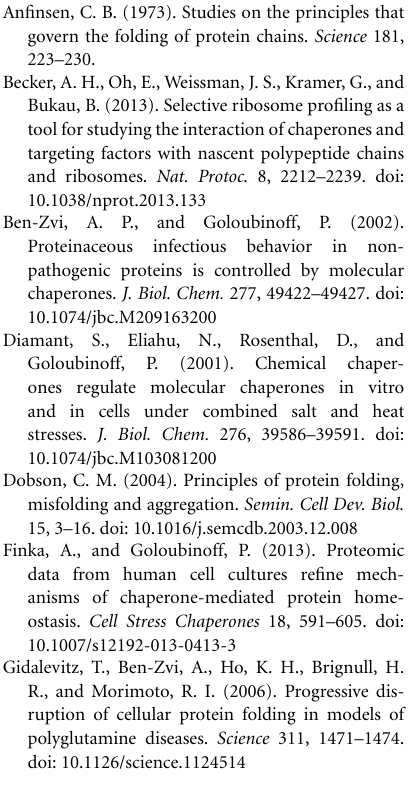
Misfolded conformers can also induce misfolding of other metastable polypeptides, damage membranes, and in animal cells, cause apoptosis and tissue loss, aging and degenerative diseases. Whereas molecular chaperones can prevent and actively repair structural damages in reversibly damaged aggregates, proteases can degrade and recycle irreversibly damaged protein